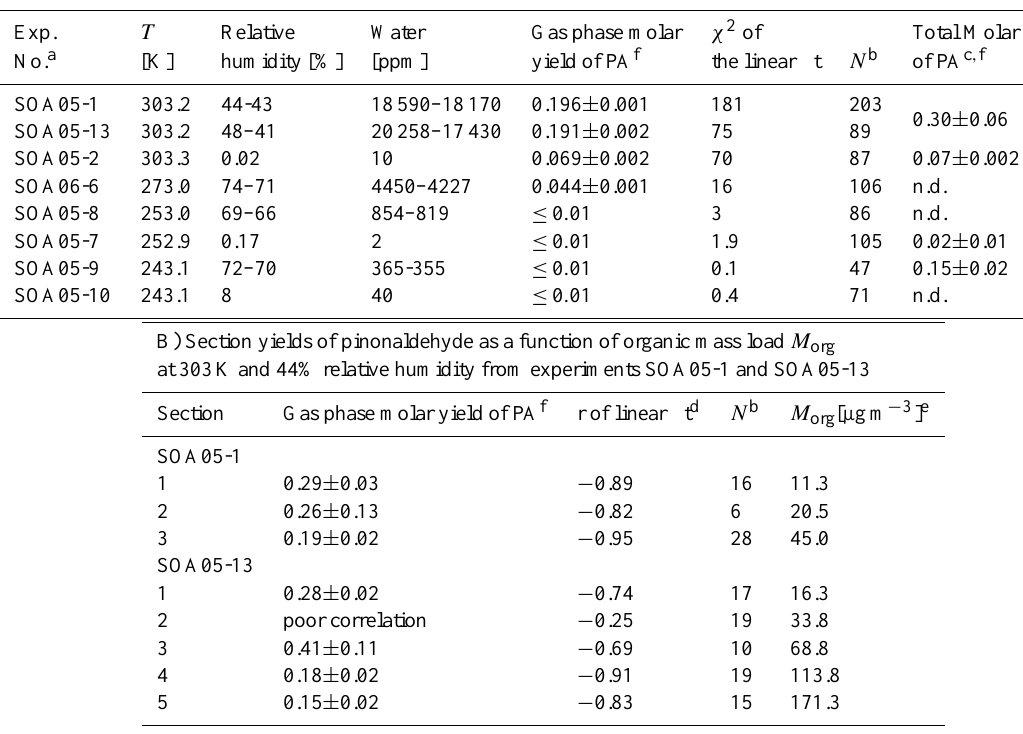
Table 1. Molar Yields of